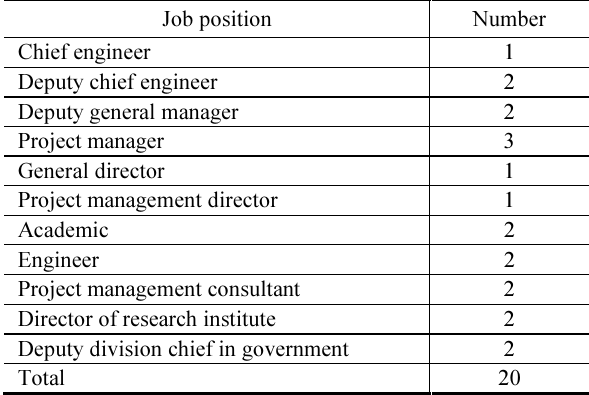
Table 3. The job positions of the